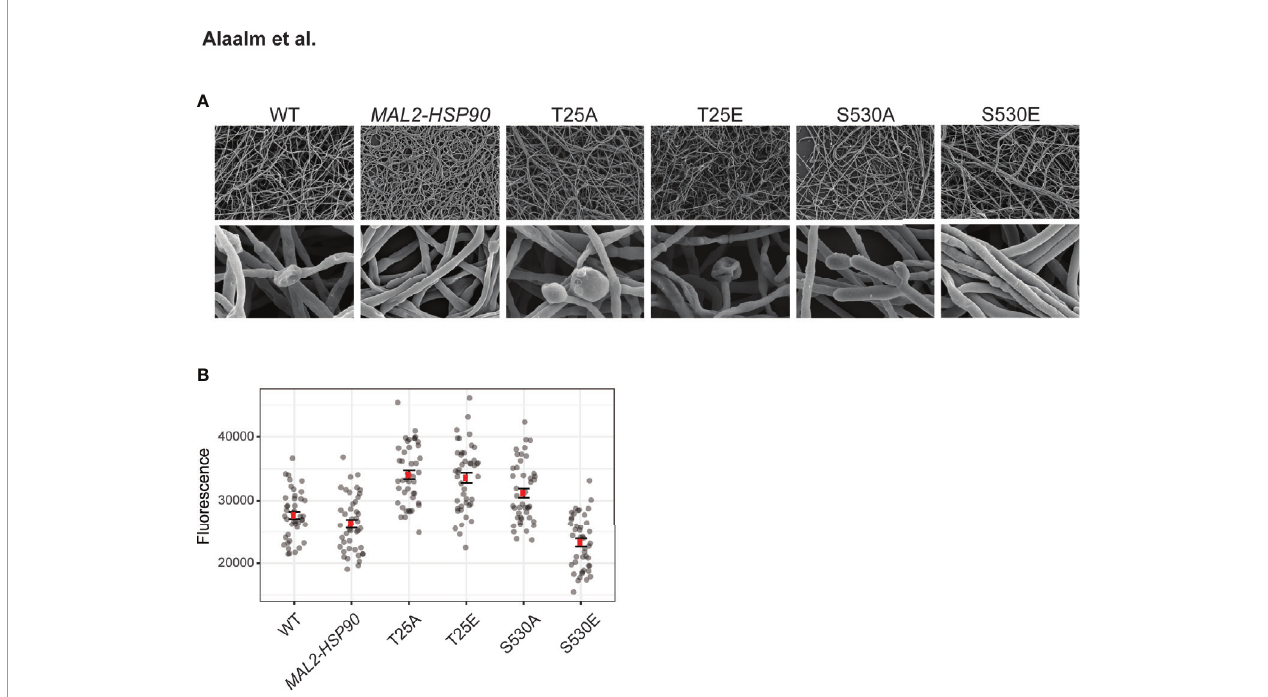
FIGURE 5 | Bio fi lm architecture remains unaffected by Hsp90 phosphorylation. (A) Scanning electron microscopy images of mature bio fi lms at 800x (top) and 8,000x (bottom) magni fi cation reveal bio fi lm architecture between the wild type, the control and the phospho-mutants to be indistinguishable upon visual inspection. (B) Bio fi lm cell viability, measured as reduction of resazurin at 590 nm, is signi fi cantly reduced in strain S530E. 44 replicates were measured per